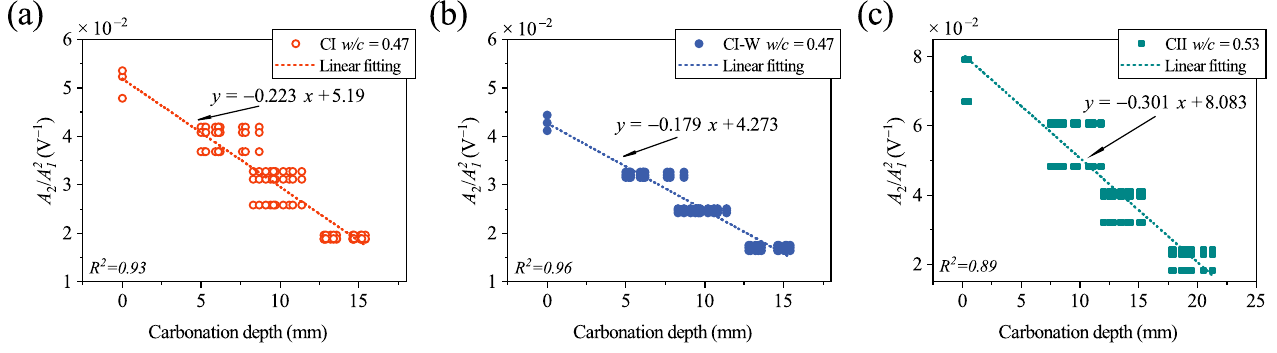
Figure 12. Non-linear parameters versus carbonation